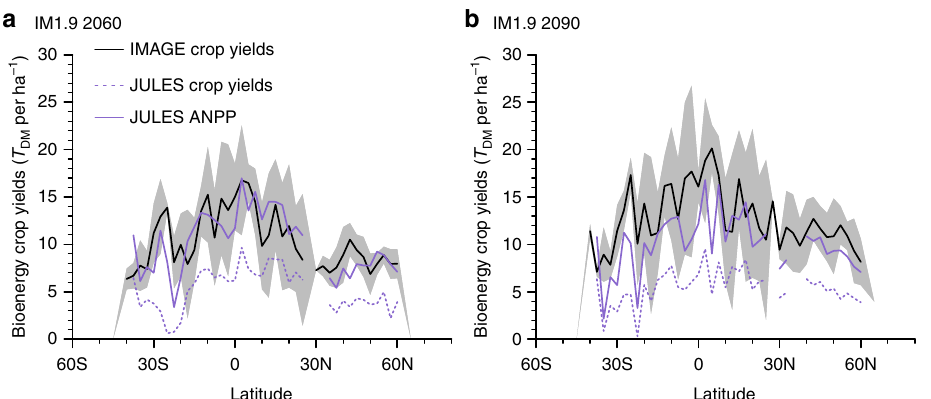
Fig. 7 Comparison of bioenergy crop yields as simulated by JULES and IMAGE. Zonal mean non-woody potential biomass from IMAGE (black lines) ± 1 standard deviation (shading) in 2060 ( a ) and 2090 ( b ) with IM1.9 compared to JULES: solid line is the aboveground NPP, and the dashed line is